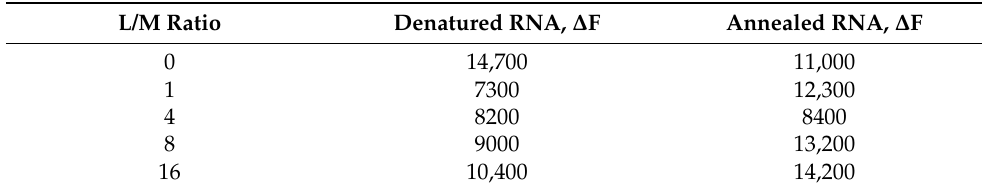
Table 1. Change in fluorescence ∆ F (between 20 and 65 ◦ C) for denatured and annealed FM1 CUG ×